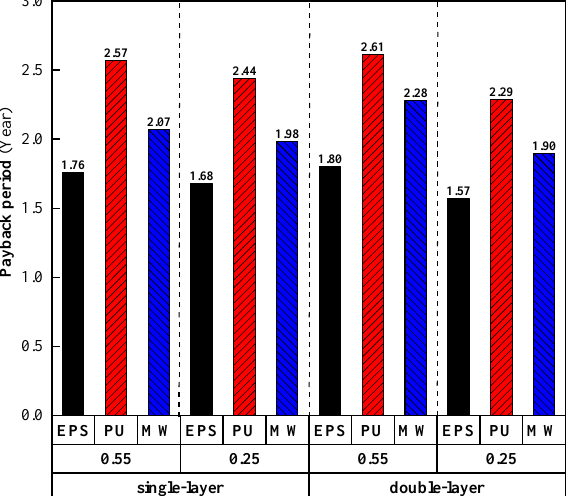
Figure 10. Payback period of roof thermal insulation of buildings.